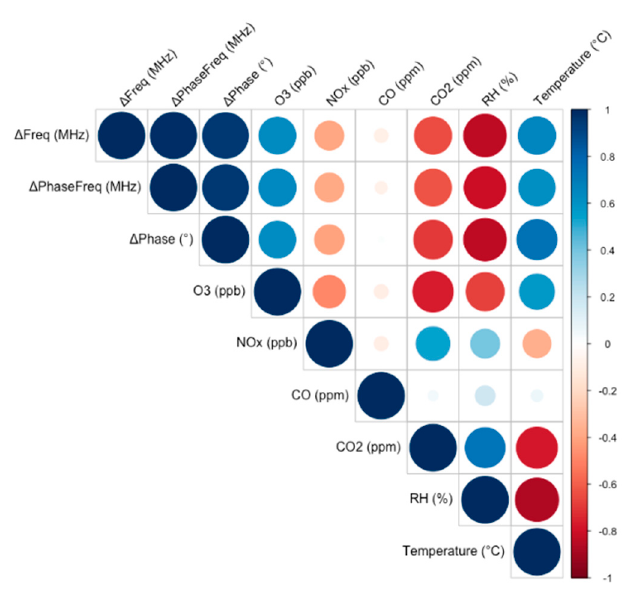
Figure 11. Correlation analysis.